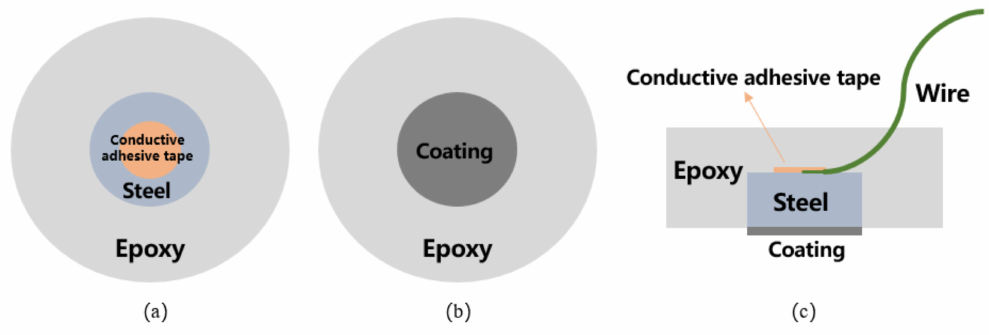
Figure 1. A schematic map of the prepared sample: ( a ) top view; ( b ) bottom view; ( c ) side view. For comparison, 4 samples denoted as G1, G2, G3, and G4, were prepared, with